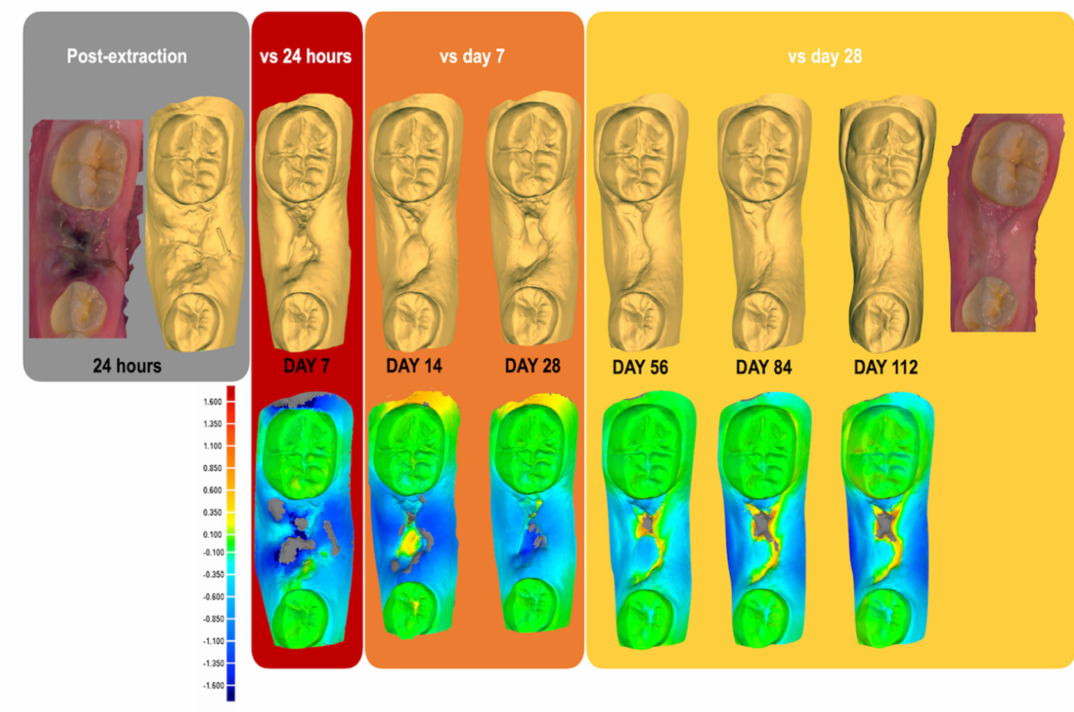
Figure 2. Intraoral scans and 3D analysis demonstrating the progression of residual alveolar ridge remodelling and soft tissue invagination post-extraction of tooth 46 over a period of 112 days, achieved through superimposition and 3D deviation analysis of sequential intraoral scans. The grey colour indicates the absence of